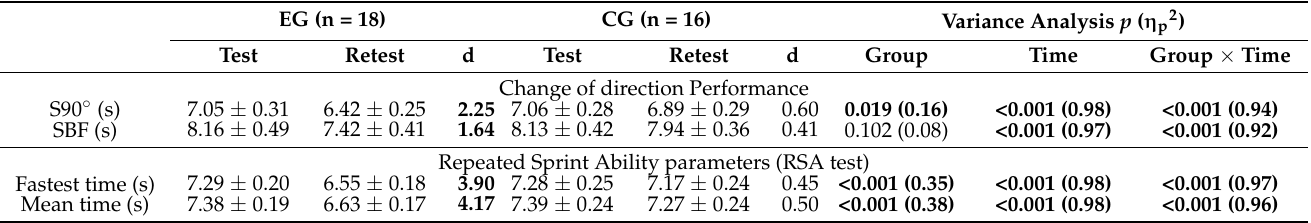
Table 5. Change of direction ability and Repeated Sprint Ability test performances depending on groups (EG vs. CG) before and after 8-week intervention. Meaningful effects (criteria: p < 0.05 and η p2 > 0.15 and d > 0.80) and the largest effect sizes for each parameter are highlighted in bold.